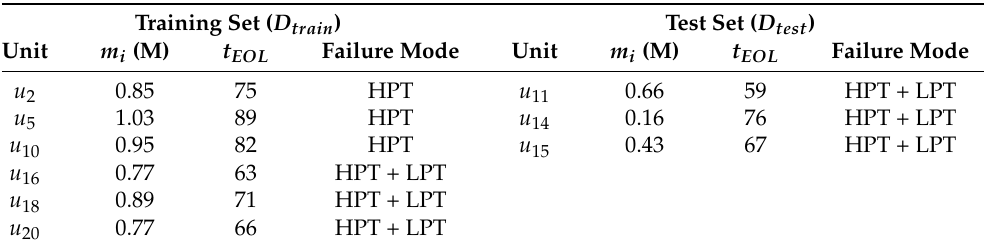
Table 2. Overview of each unit in the DS02 sub-dataset of N-CMAPSS w.r.t. the number of samples m i (in millions), the end-of-life time t EOL , and the failure